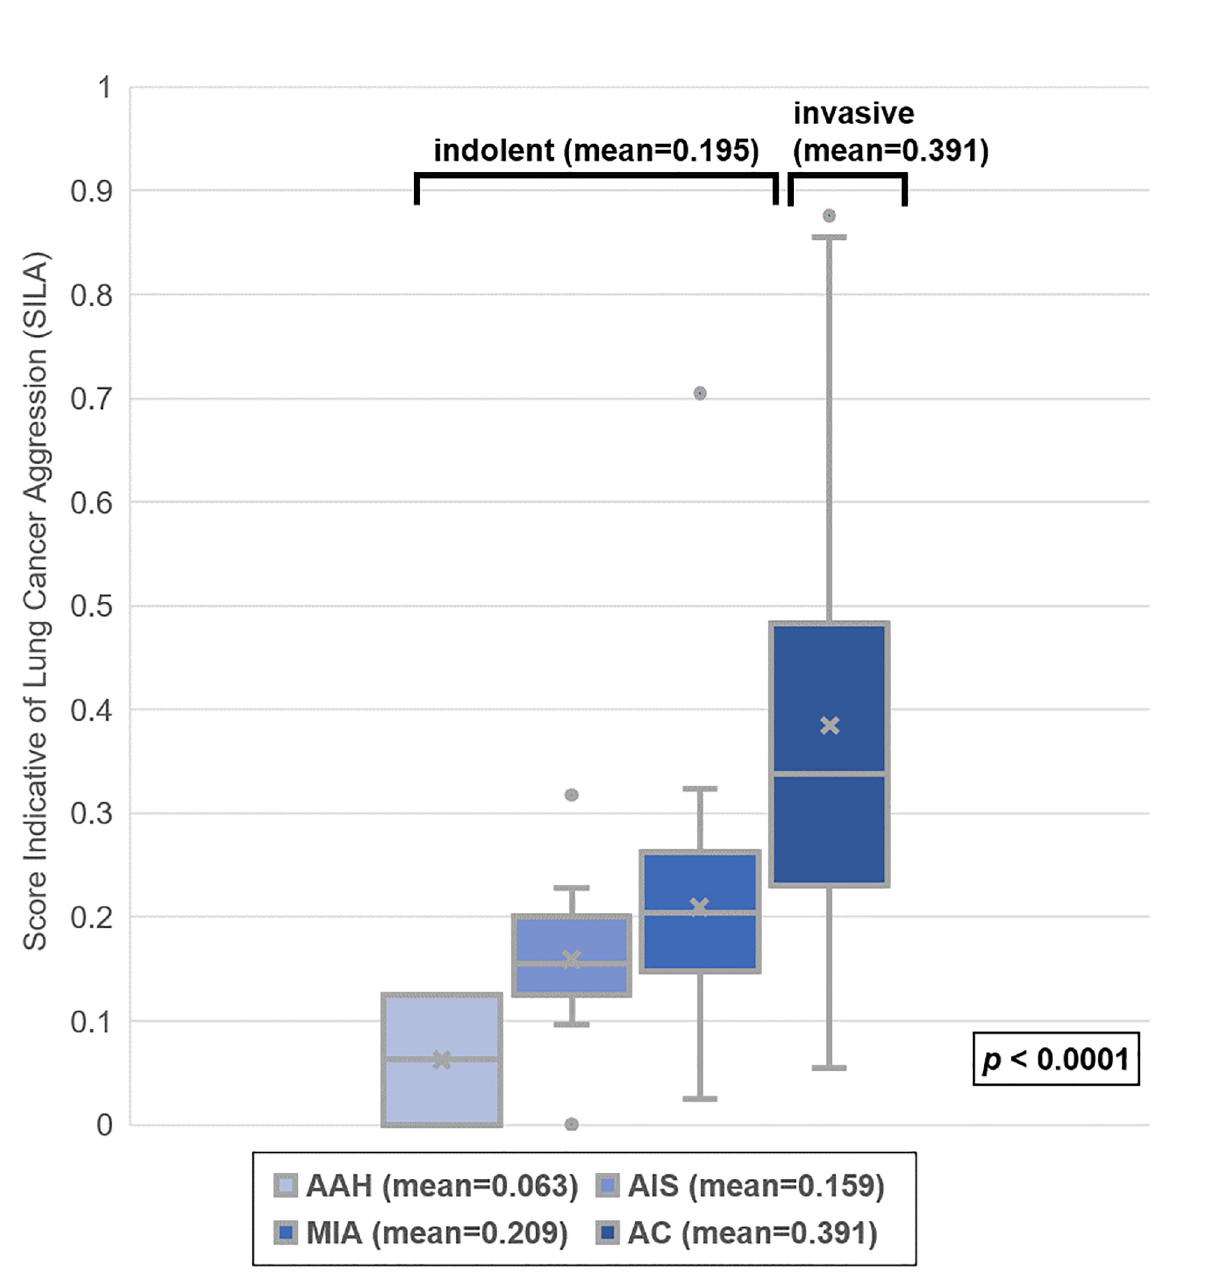
Fig 2. The distribution of score indicative lung cancer aggression (SILA) for each subtype. The mean value and the distribution of the SILA between the indolent and the invasive nodules were statistically significant, and also among the atypical adenomatous hyperplasia (AAH), the adenocarcinomas in situ (AIS), and the minimally invasive adenocarcinoma (MIA) were